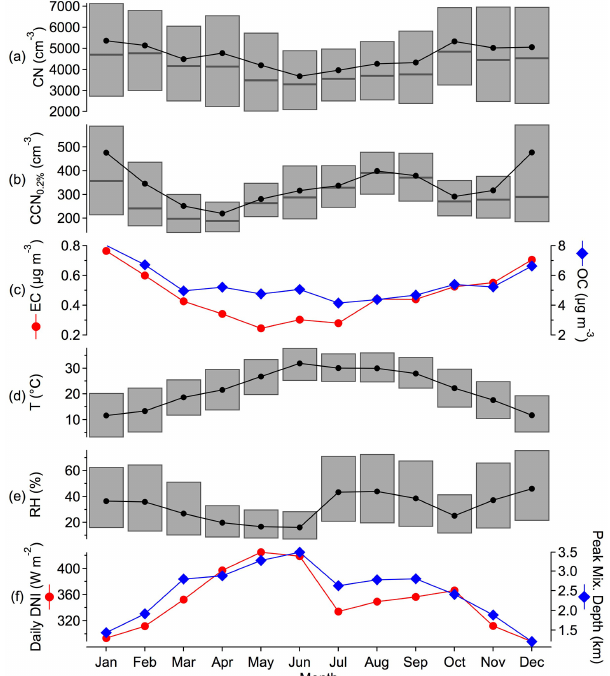
Figure 1. Monthly statistics of (a) CN, (b) CCN (0.2%), (c) OC and EC, (d) temperature, (e) RH and (f) direct normal irradiance (DNI). Circles, diamonds and the lines connecting them represent monthly averages. For (a) CN and (b) CCN, bars represent median and interquartile range of sub-monthly variability of the 1h aver- aged data. For (d) temperature and (e) relative humidity, bars rep- resent monthly extremes, as measured by 5 and 95% levels of the 1min average data. DNI is presented using 24h averages so that it includes the effect of the changing length of day with season, and peak mixing depth is calculated using the 16:00 radiosonde